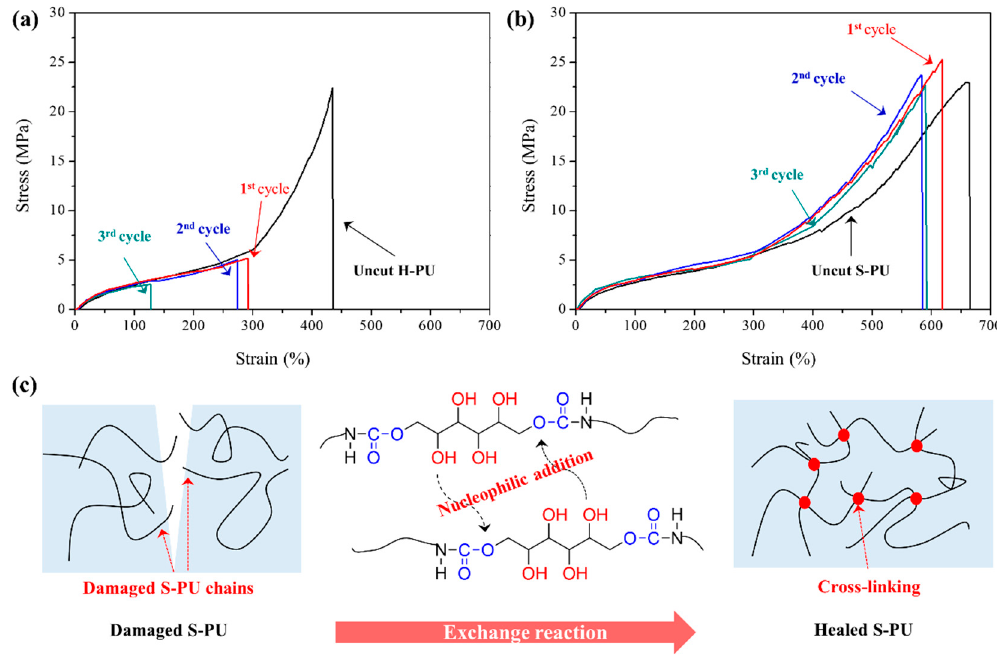
Figure 7. Results of self-healing at 130 °C for 120 min: ( a ) tensile properties of H-PU after self-healing; ( b ) tensile properties of S-PU after self-healing; ( c ) schematic of the self-healing mechanism and configurational change of typical S-PU after the exchange reaction. Table 4. Tensile properties and gel fraction of S-PU and H-PU after repeated cutting/self-healing cycles.